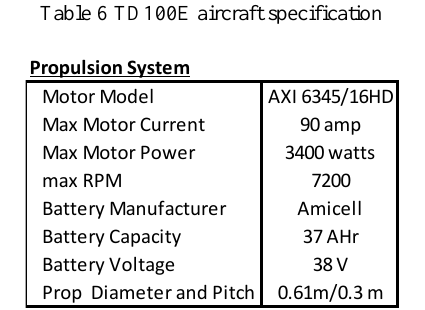
Table 7: TD100E propulsion system